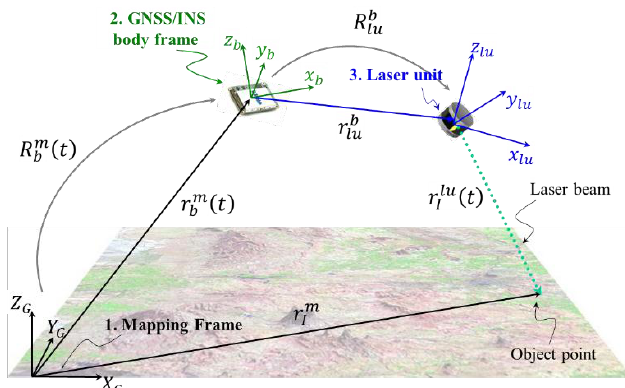
Figure 3. Illustration of point positioning of a UAV-based Light Detection and Ranging (LiDAR) system.